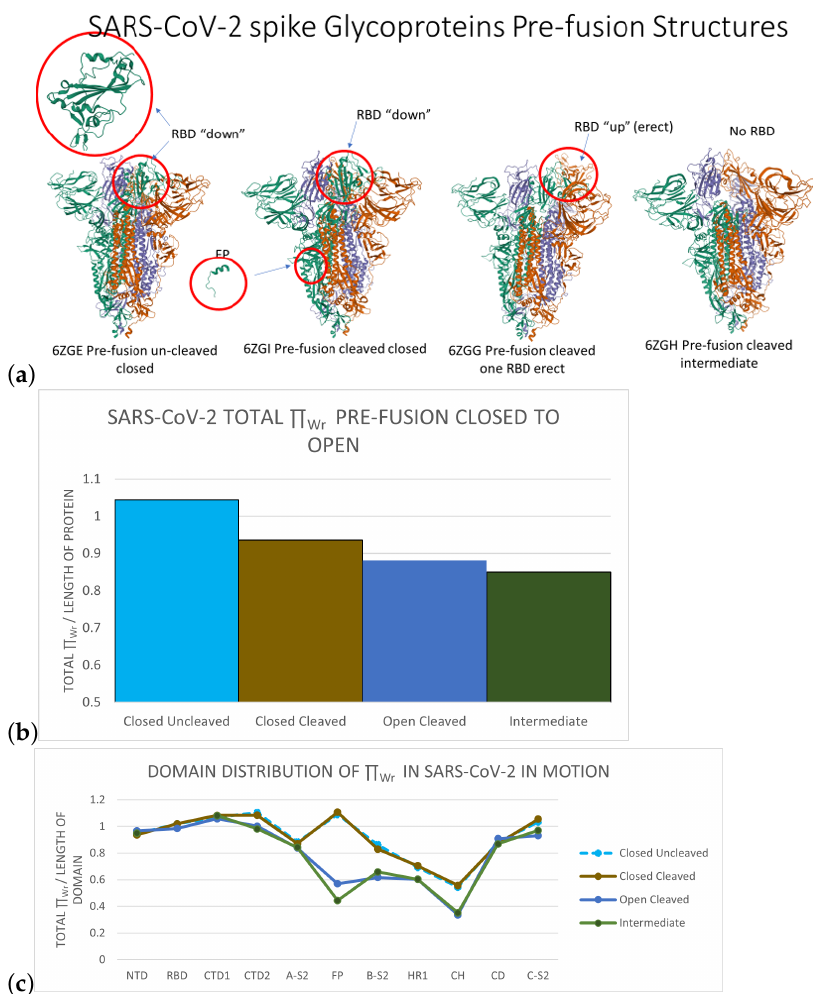
Figure 3. ( a ) From left to right, snapshots of SARS-CoV-2 pre-fusion Spike protein at four stages: uncleaved closed (6ZGE, all 3 RBD down), cleaved closed (6ZGI, all 3 RBD down, proteolytically cleaved), cleaved open (6ZGG, one RBD up), and intermediate (6ZGH, RBD has been removed). ( b ) The normalized total local Π Wr for SARS-CoV-2 protein at the four pre-fusion stages. ( c ) The distribution of the normalized total local Π Wr -values for SARS-CoV-2 protein domains at the four pre-fusion stages. Crystal structure images were pulled from the Protein Data Bank